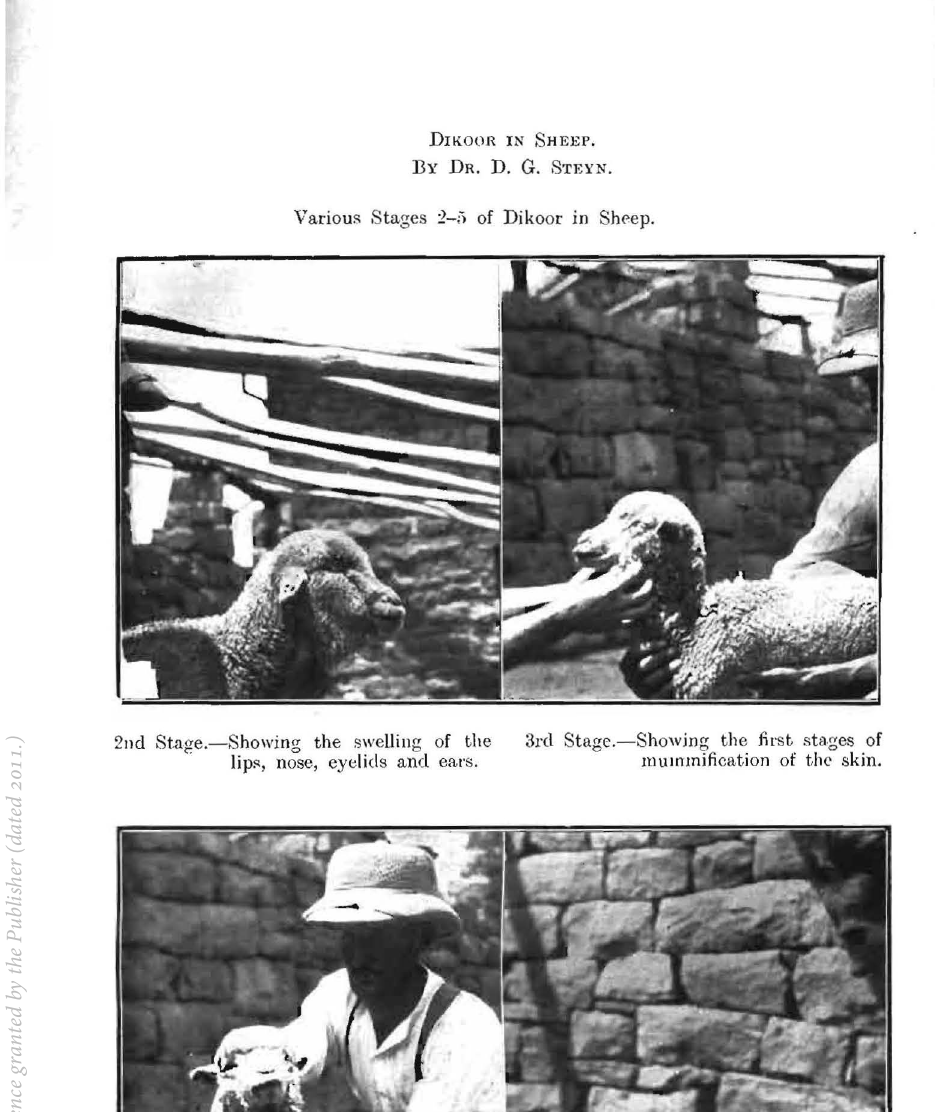
:'it.h Stage.- Ears n,11<1 lilJS in the process 01 dropping